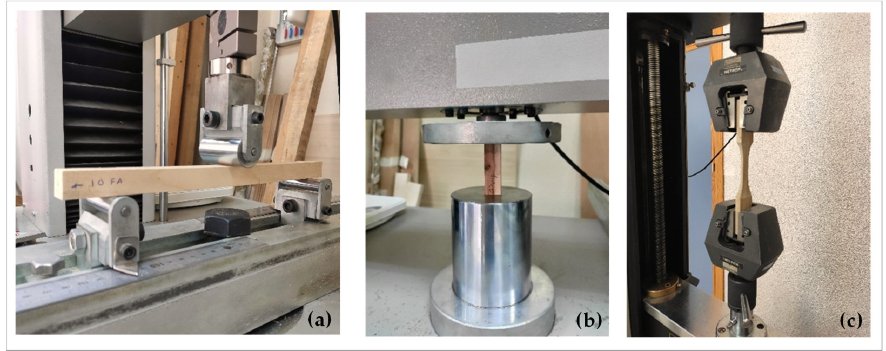
Figure 4. Mechanical tests of bending strength ( a ); axial compression strength ( b ); and tension parallel to grain ( c ).